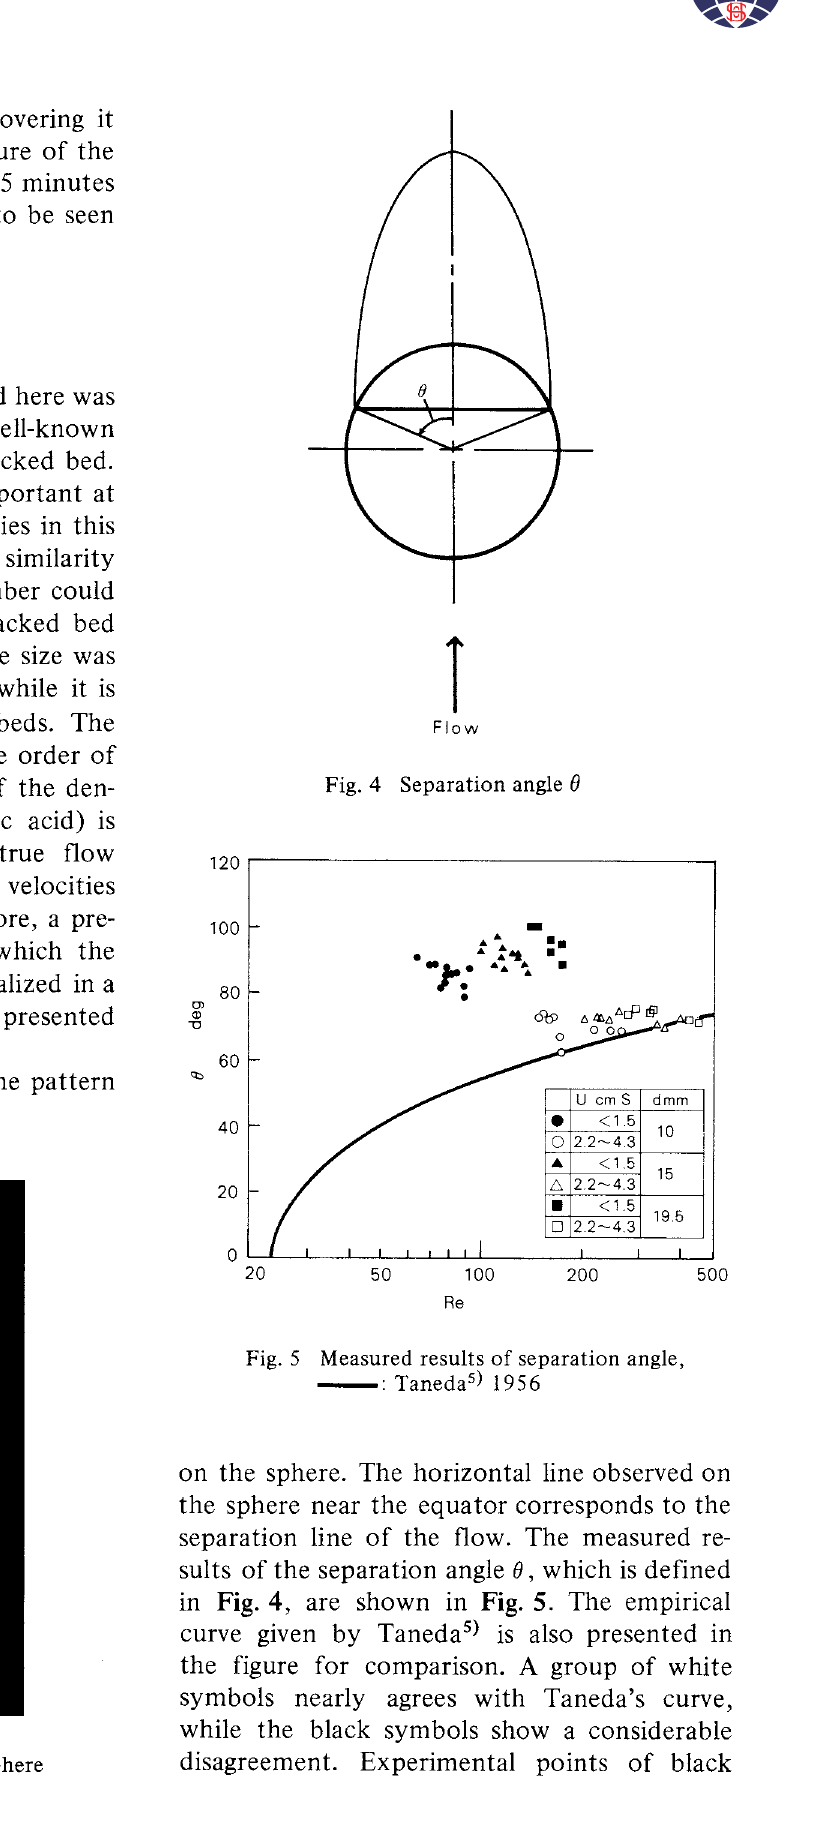
Fig. 3 Separation line on a single sphere